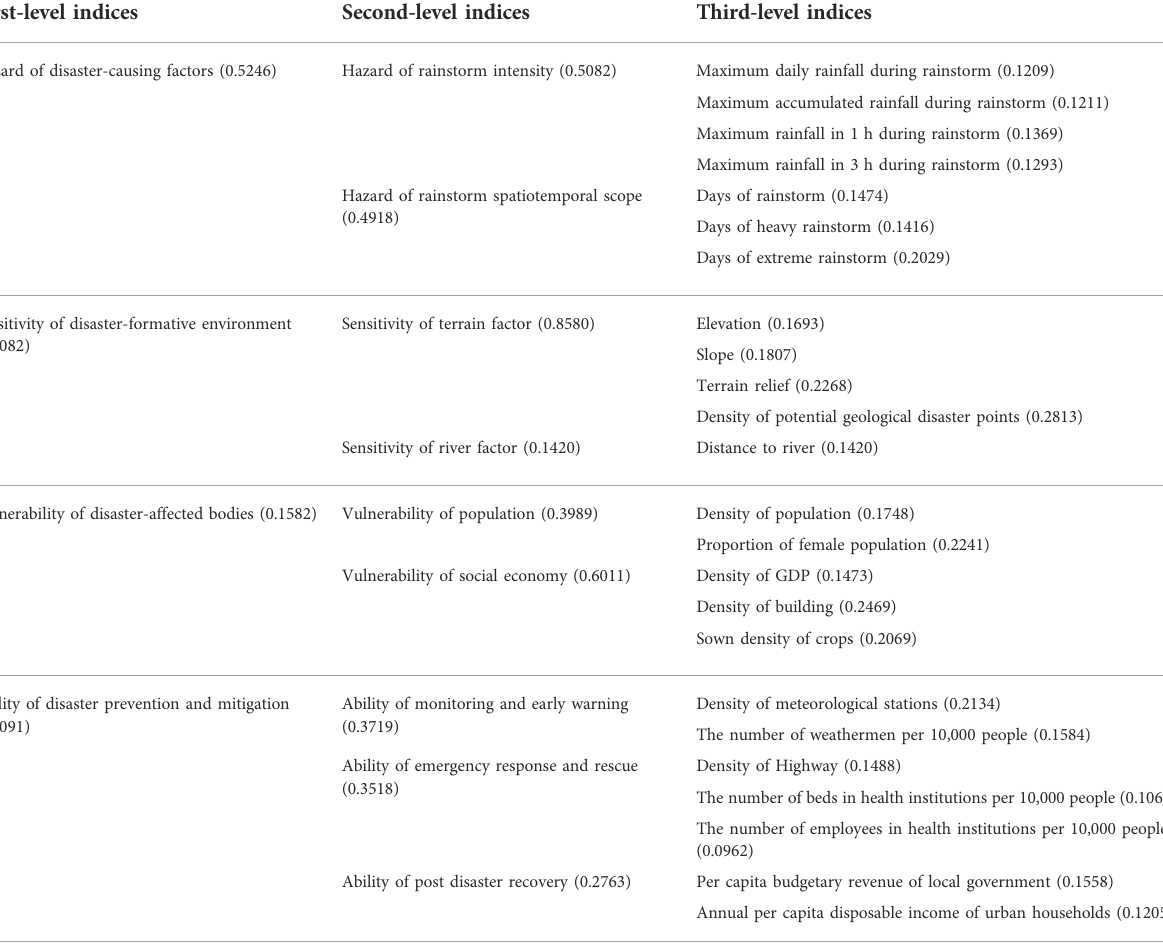
TABLE 2 Indices system of the non-typhoon rainstorm disaster risk assessment of Fujian Province,